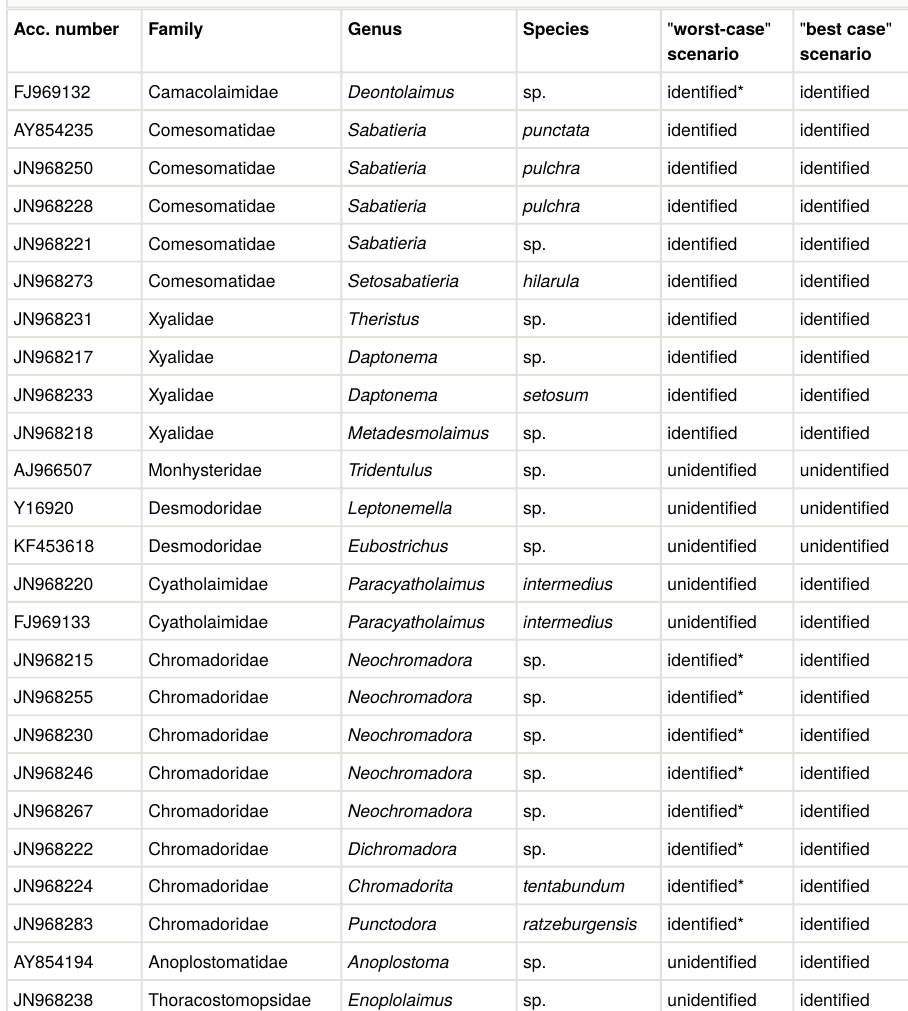
Table 6. GenBank accession numbers and classi fi cation of sequences used in the fi nal comparison of "worst case" and "best case" scenarios, and their identi fi cation outcomes. * denotes taxa placed in monophyletic clade but with low